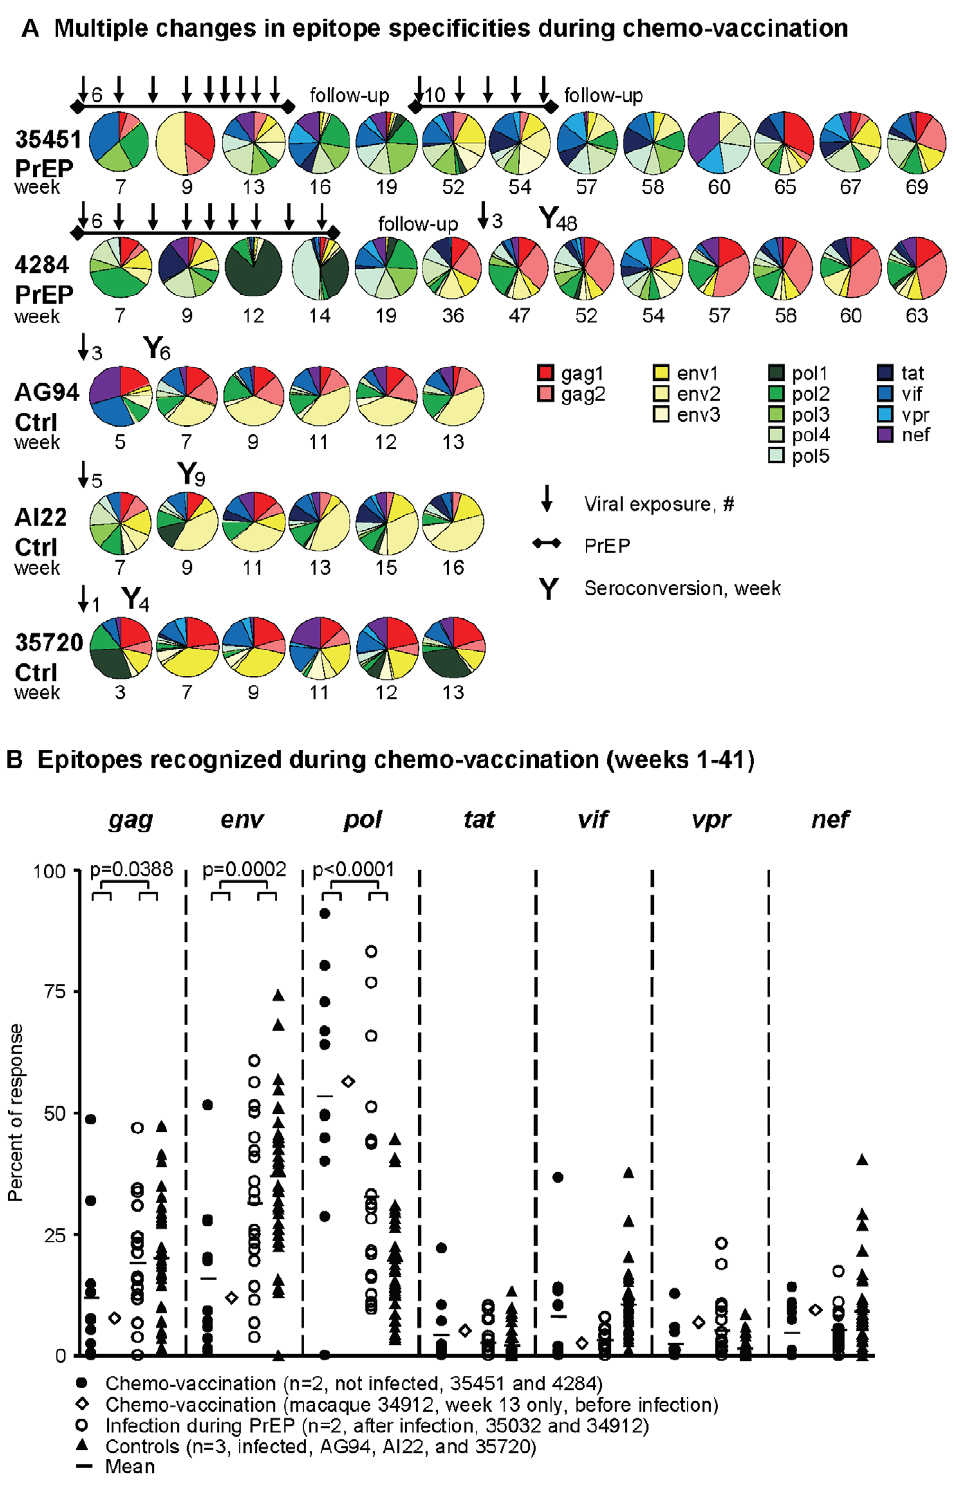
Figure 3. Epitope specificity of T cells induced by chemo-vaccination. A : T cell specificities in PrEP-protected macaques 4284 and 35451 change rapidly during SHIV exposures and PrEP, while they remain more consistent in infected control macaque AG94, and in 4284 after infection. T cell specificities were determined by IFN c -ELISPOT with 14 peptide pools represented by the indicated colors. The pie charts depict percentages of contributions to the T cell response. Arrows indicate time point of virus exposures, adjacent numbers indicate how many exposures were given. Seroconversion is recorded by ‘‘Y’’; numbers indicates the study week of seroconversion. B : T cells induced by chemo-vaccination appear focused on epitopes derived from the pol region. IFN c -ELISPOT responses to 14 peptide pools were combined for the indicated gene products; their contribution to the response (all 14 peptide pools) was calculated. All IFN c -ELISPOT results from week 1–41 are depicted. N refers to number of macaques in the 4 specified groups. P-values were obtained by unpaired, two-sided student’s t-tests comparing all results before infection (12 time-points from 3